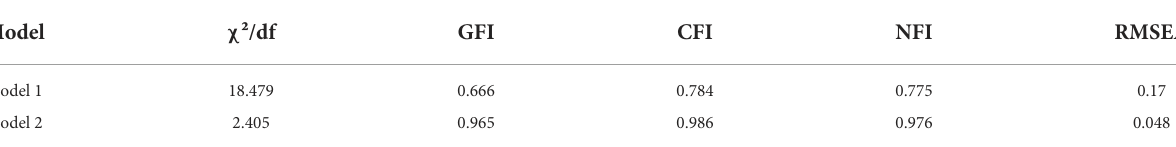
TABLE 4 Model fitting